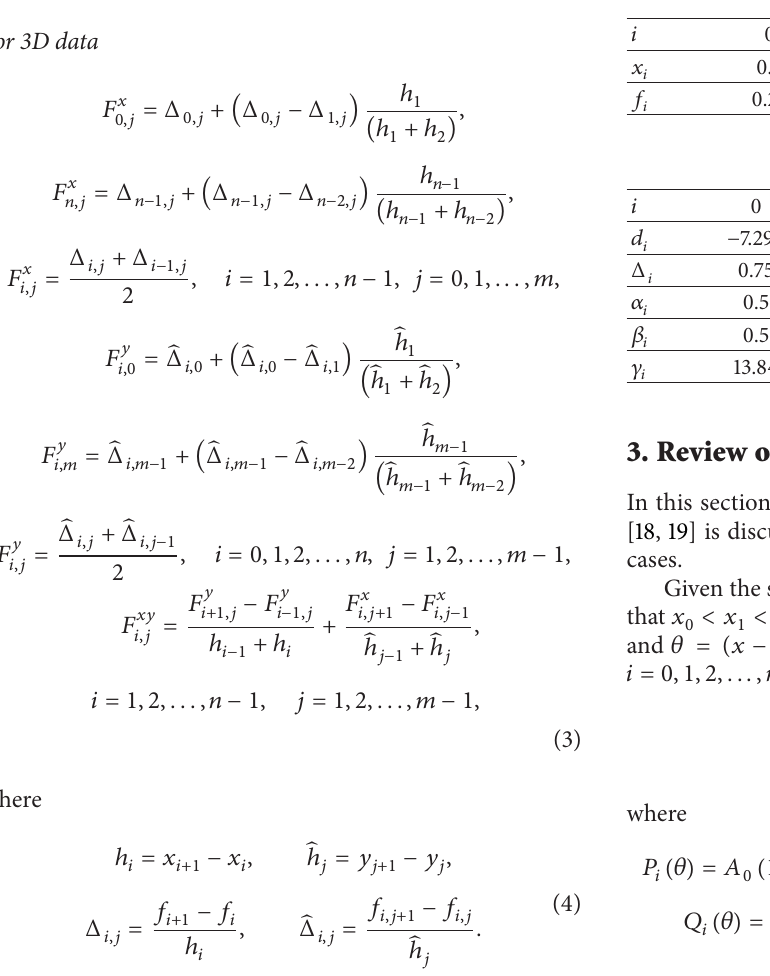
Table 1: Positive data from the study by Hussain et al. [28].